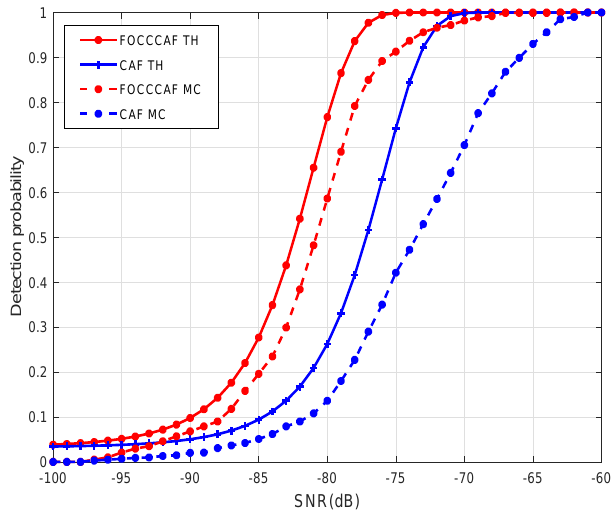
Figure 5. Detection performance of the proposed